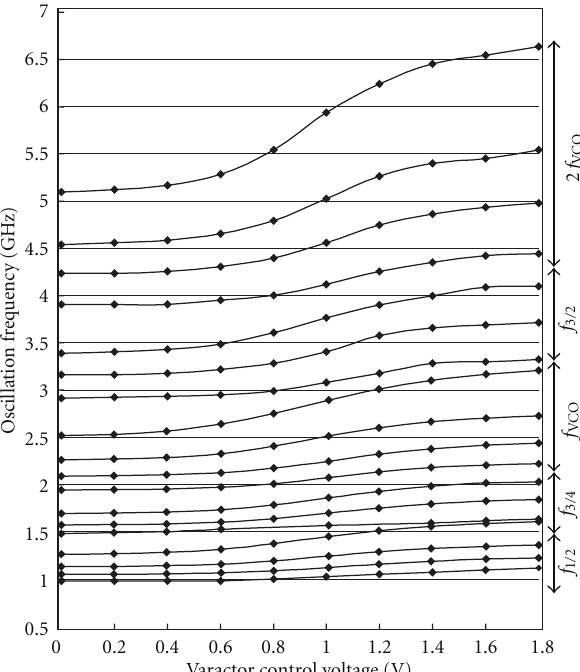
Figure 8: Measured tuning characteristics of the proposed VCO, which exhibits from 0.98 GHz to 6.6 GHz oscillation (149%).